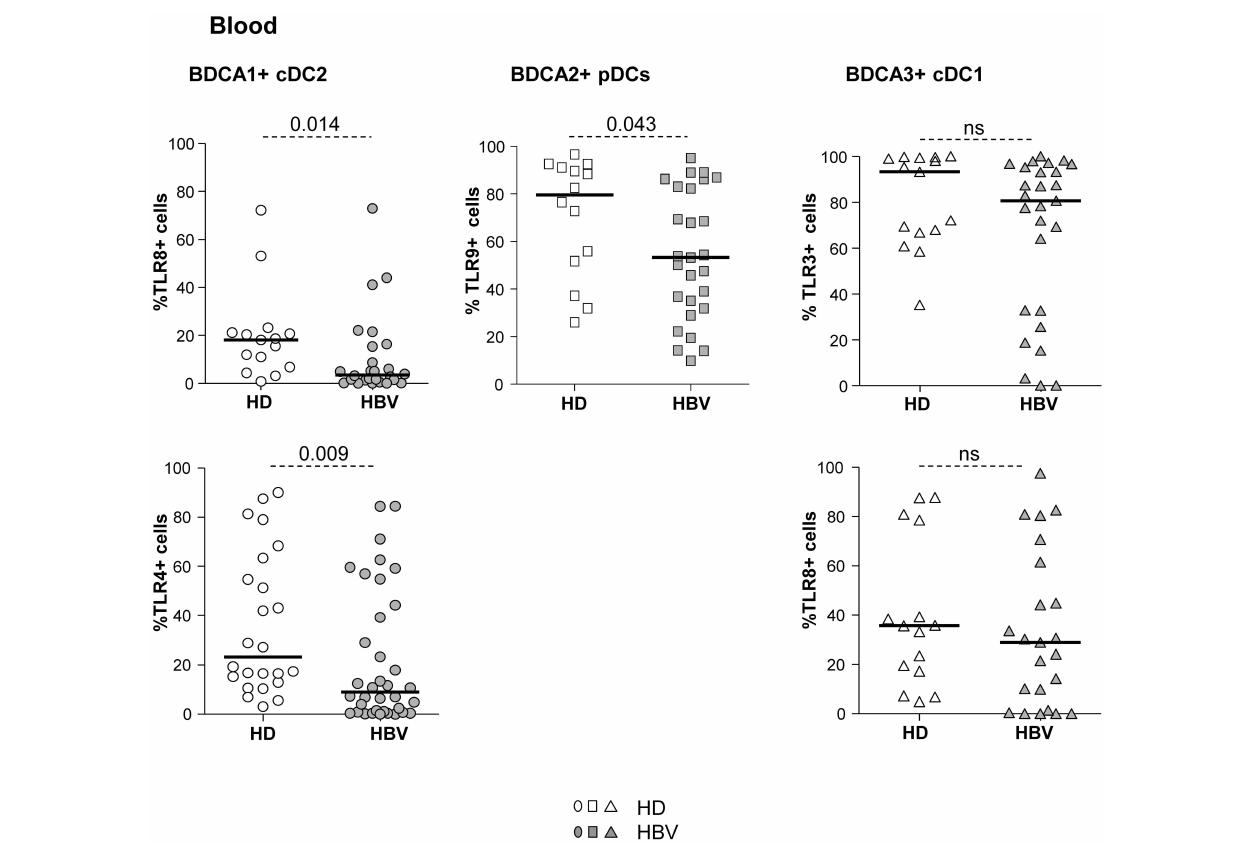
FIGURE 3 | Impaired expression of TLR4, TLR8, and TLR9 in peripheral DC subsets from chronic HBV patients. Surface (TLR4) or intracellular (TLR3, TLR8, and TLR9) expression of TLRs was evaluated by flow cytometry on peripheral DC subsets from fresh PBMCs isolated from HD and HBV patients. Percentages of cDC2, pDCs, and cDC1 expressing the TLR molecules within the corresponding DC subset. Open symbols, HD ( n = 14–15 for TLR3,8,9, and n = 27 for TLR4); filled symbols, patients with chronic HBV ( n = 24 for TLR3,7,9, and n = 35 for TLR4). Bars indicate median. P -values were calculated using the Mann-Whitney test. P -values were calculated using Man-Whitney test (dashed